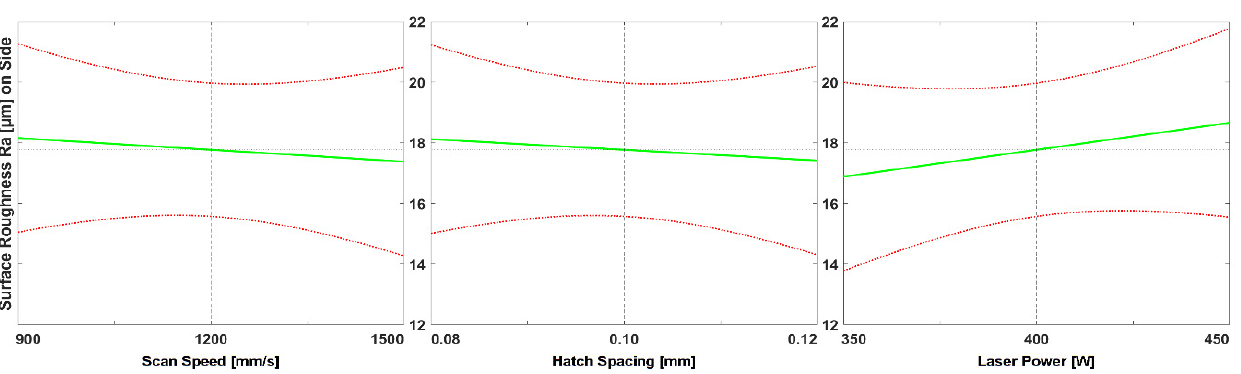
Figure 9. Effects of the interaction of parameters on the measured R a on the top surface.